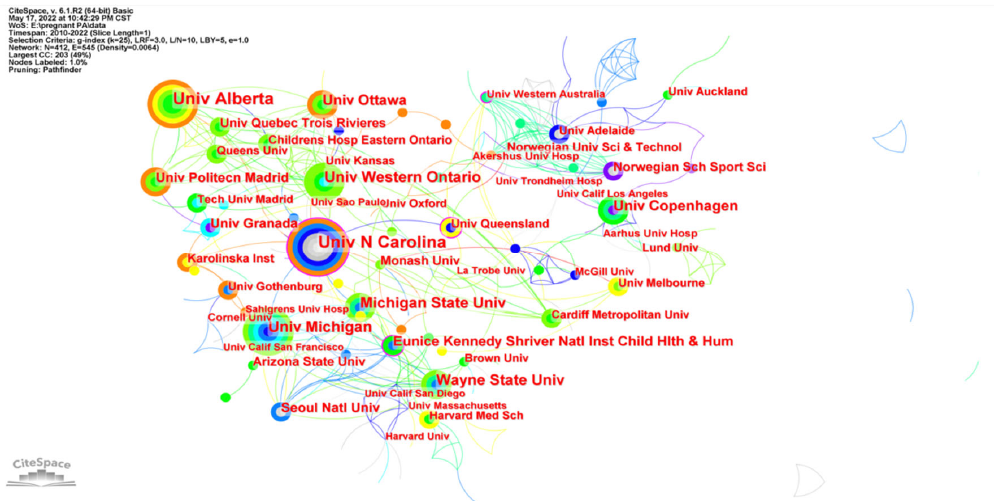
Figure 5. Co ‐ occurrence map of institutions researching physical activity during pregnancy.